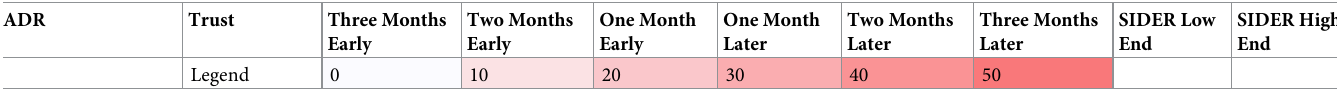
PLOS ONE | https://doi.org/10.1371/journal.pone.0243437 December8,